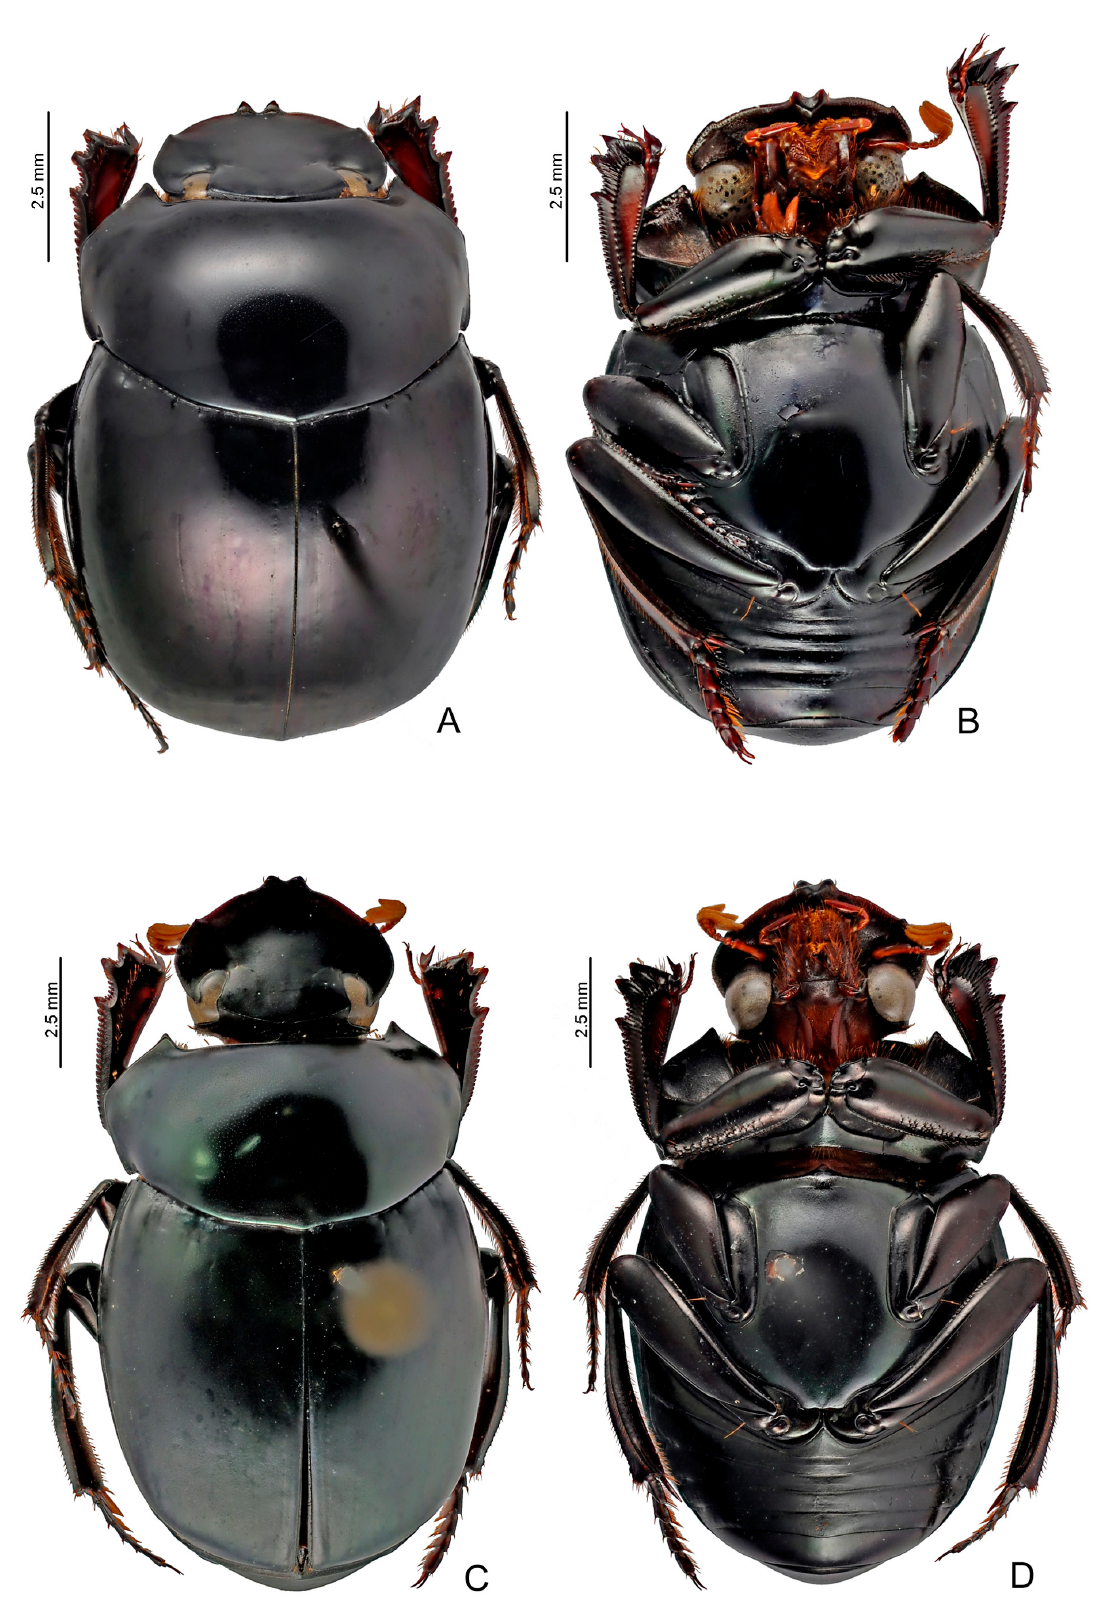
Fig. 28. A–B . Sylvicanthon aequinoctialis (Harold, 1868) comb. nov. A . Dorsal view. B . Ventral view. C–D . S. proseni (Martínez, 1949) stat. et comb. nov. C . Dorsal view. D .